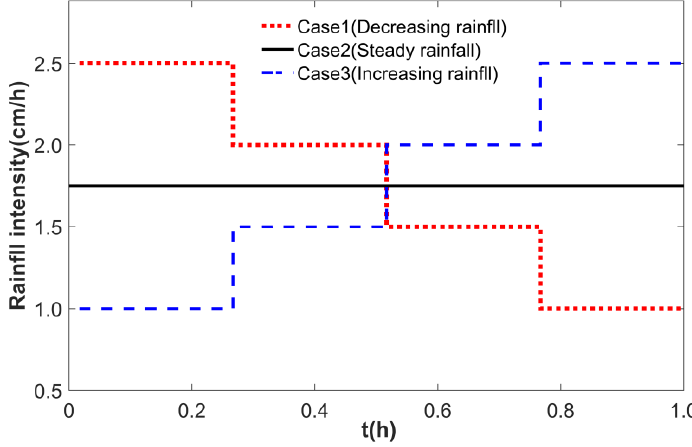
Figure 8. Diagram of three different rainfall intensity conditions.